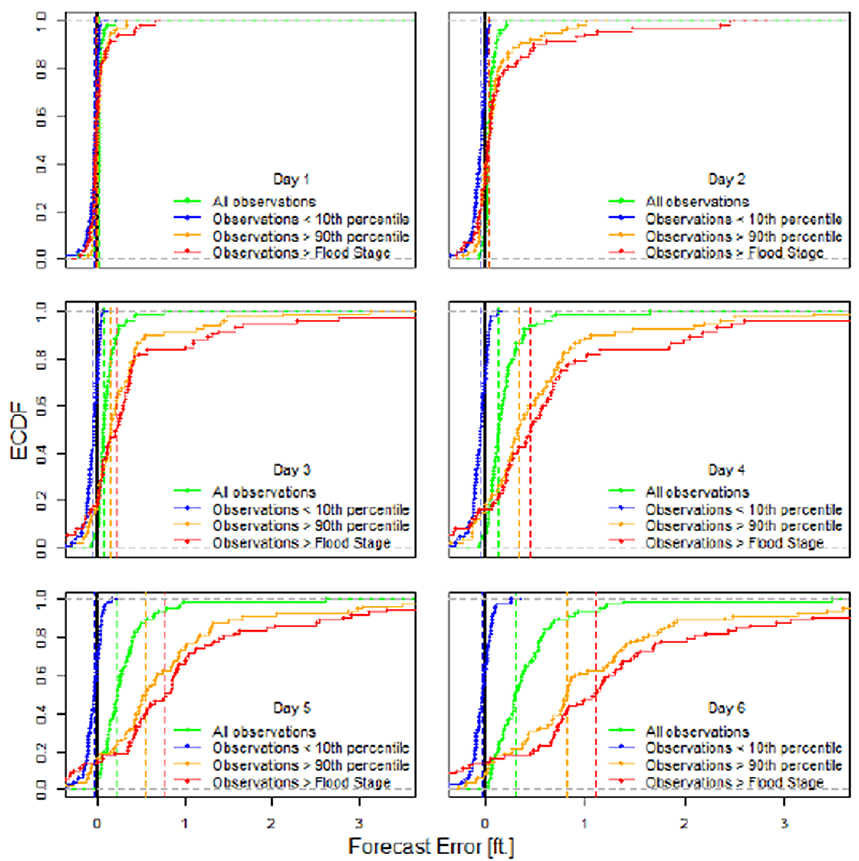
Figure 5. Empirical cumulative distribution function (ecdf) of forecast error at 82 river gauges for six lead times. Vertical lines show the median forecast error of the corresponding